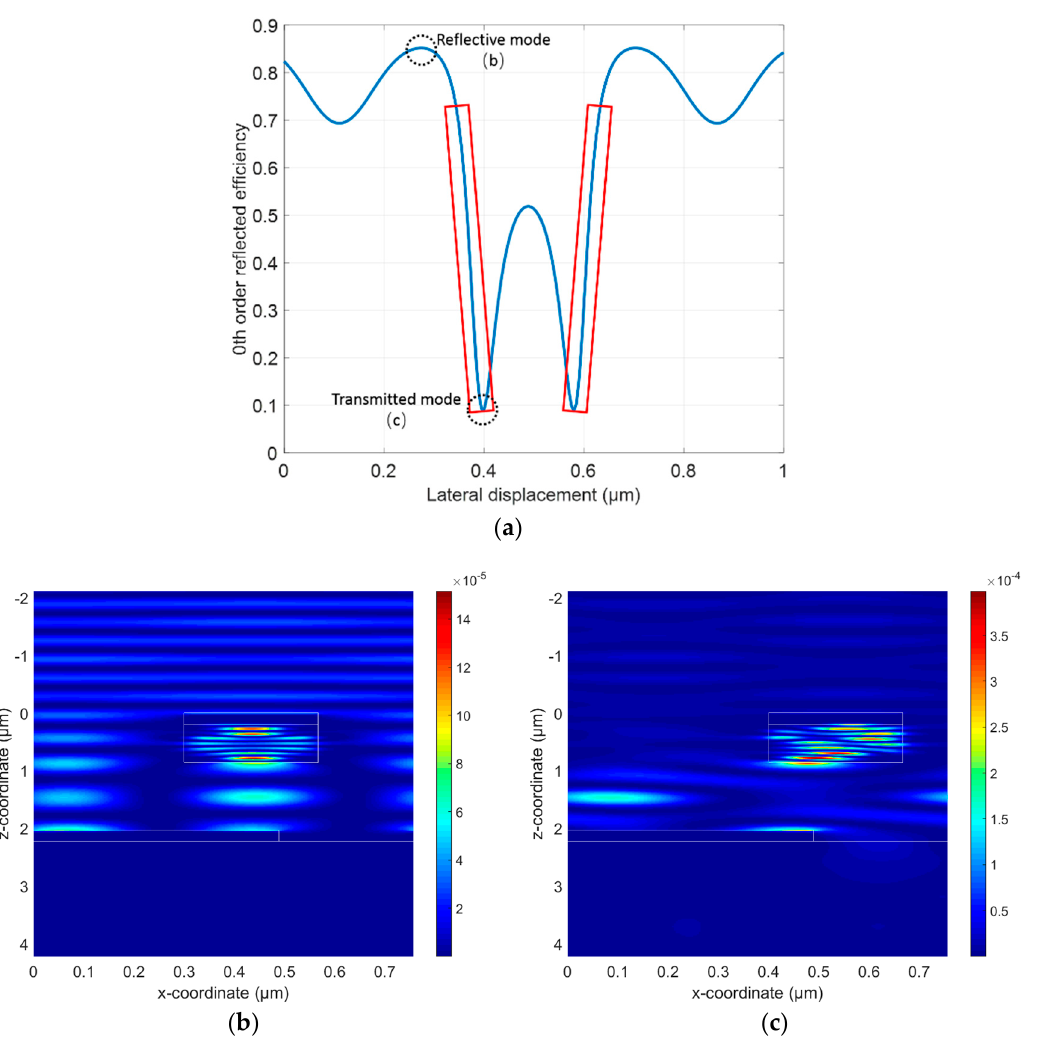
Figure 3. ( a ) Curve of the zeroth order reflectance as a function of displacement of the silicon grating along the x -axis for the optimal optical design; ( b ) reflective mode when the reflectance was the maximum in one period; the lateral shift of the upper grating was around 300 nm; ( c ) transmitted mode when the reflectance was the minimum in one period, the lateral shift of the upper grating was around 390 nm.